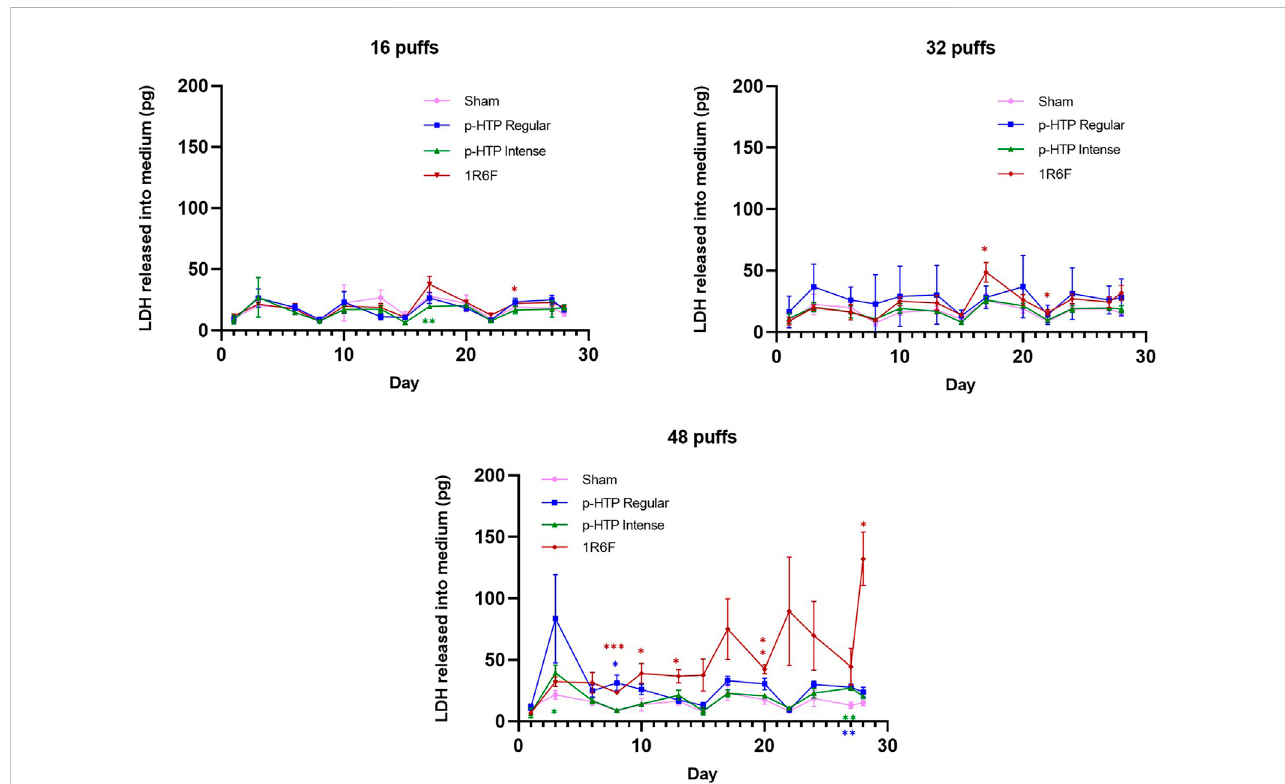
FIGURE 6 LDH released into cell culture medium and mucus from tissues exposed to 16, 32 and 48 puffs of sham (air), p-HTP Regular, p-HTP Intense and 1R6F Reference Cigarette. For each puff level, responses for p-HTP Regular, p-HTP Intense and 1R6F were statistically compared to sham measurements for each day measured (1, 3, 6, 8, 10, 13, 15, 17, 20, 22, 24, 27, 28); * p ≤ 0.05, ** p ≤ 0.005, *** p ≤ 0.001 (two-way ANOVA with Dunnett ’ s post-hoc test). Error bars represent standard deviation; n =